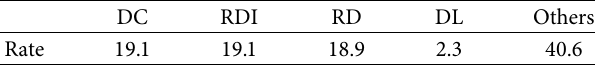
Table 6: Proportion of each fatigue detail crack (unit: %).